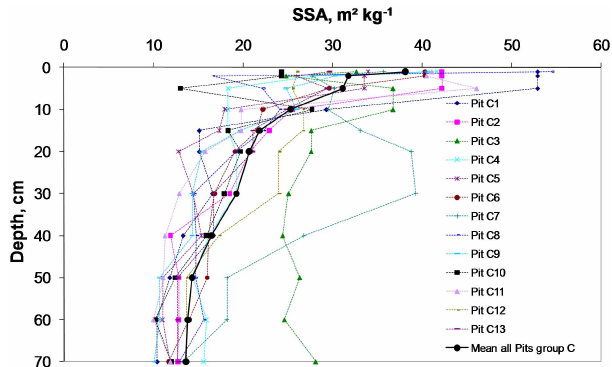
Fig. 4. SSA profiles of group C pits at Dome C.